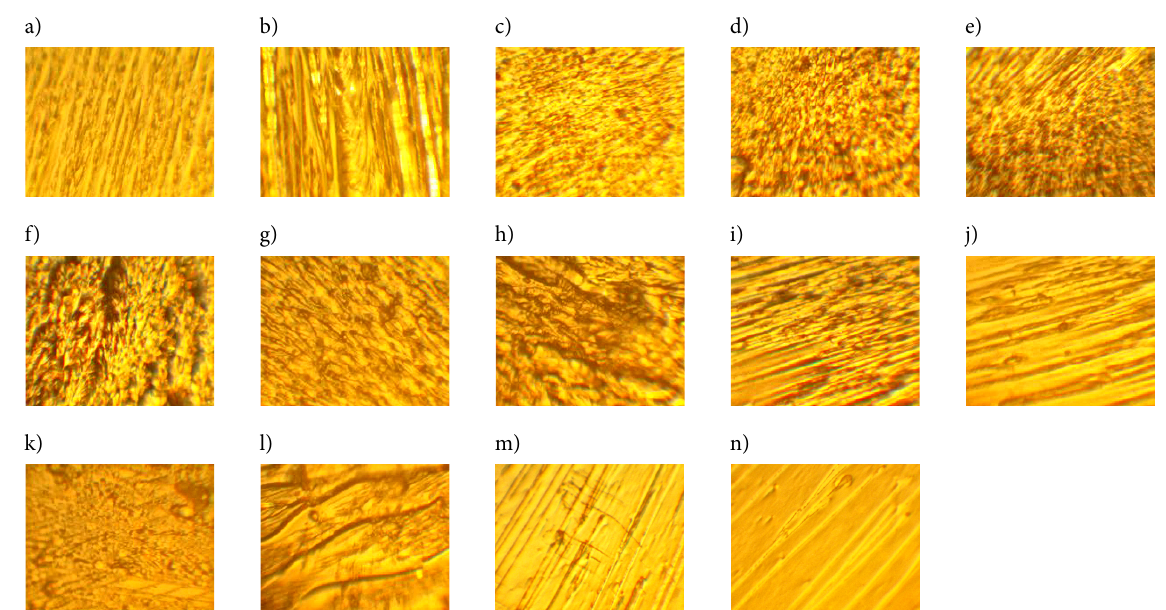
Fig. 5. Fractograms of fracture surfaces of the original matrix and MMSCO-filled epoxy CMs: a, b – epoxy matrix (control specimen); c, d – q = 0.025 pts. wt. of the filler; e, f – q = 0.050 pts. wt. of the filler; g, h – q = 0.100 pts. wt. of the filler; i, j – q = 0.250 pts. wt. of the filler; k, l – q = 0.500 pts. wt. of the filler; m, n – q = 1.000 pts. wt. of the filler;